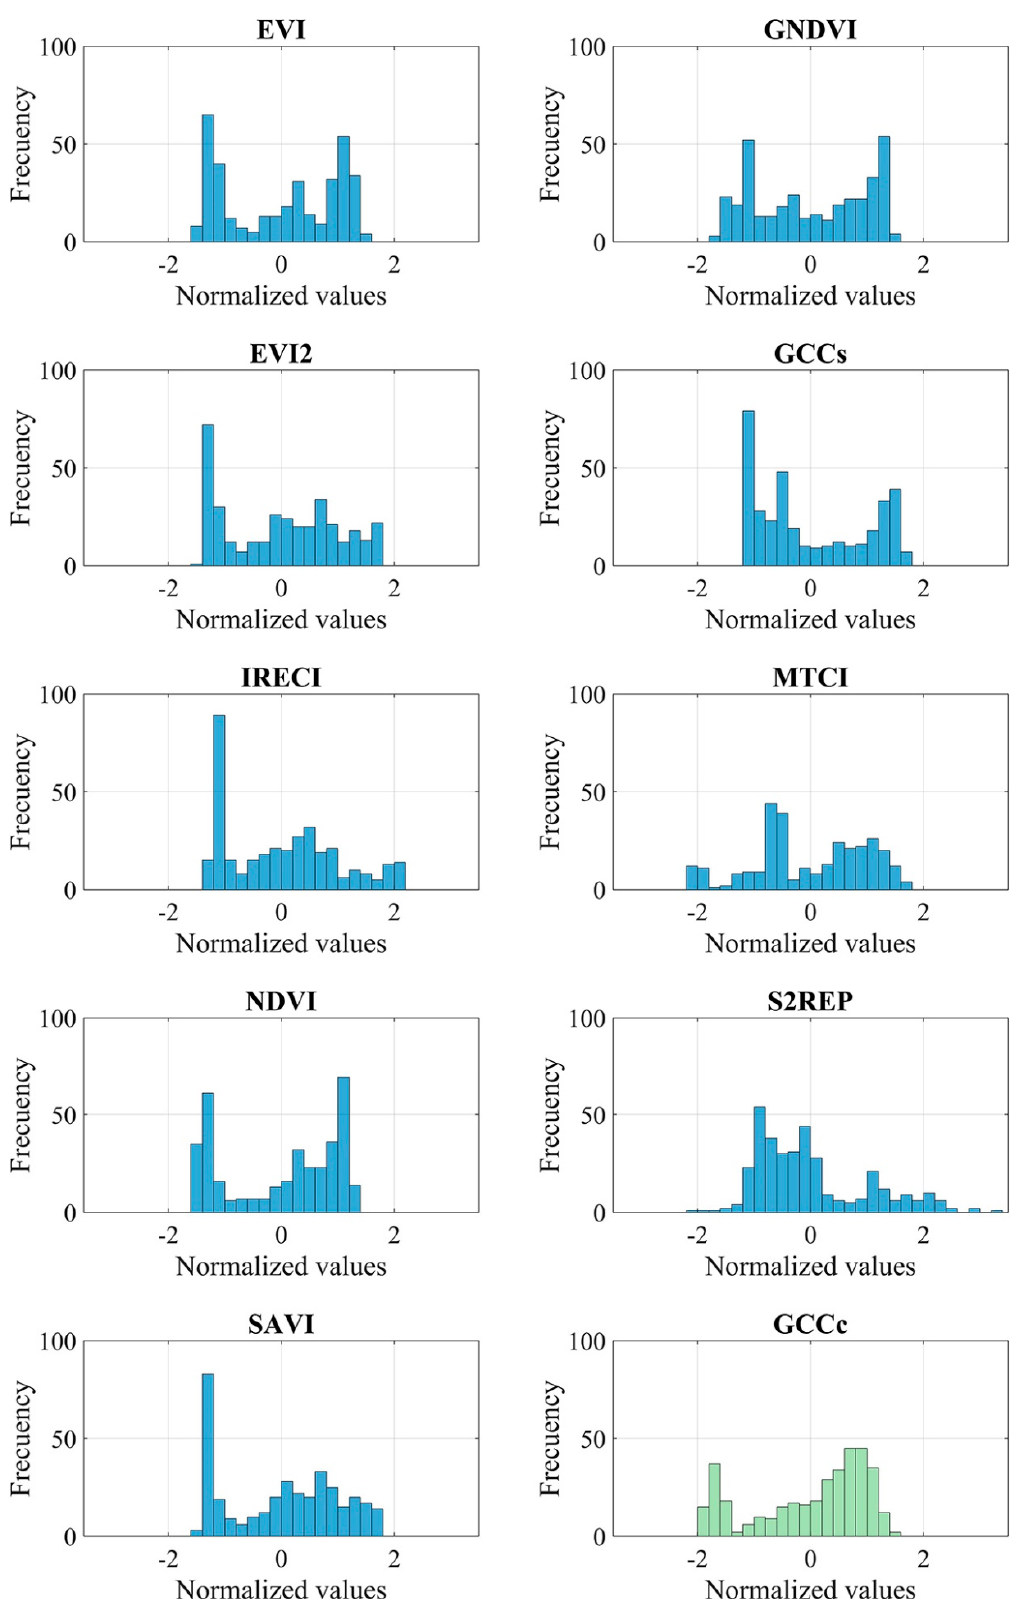
Figure 4. Histograms of vegetation index (VI) normalized values in the study area during 2018. Blue: satellite VIs; Green: Digital camera index.